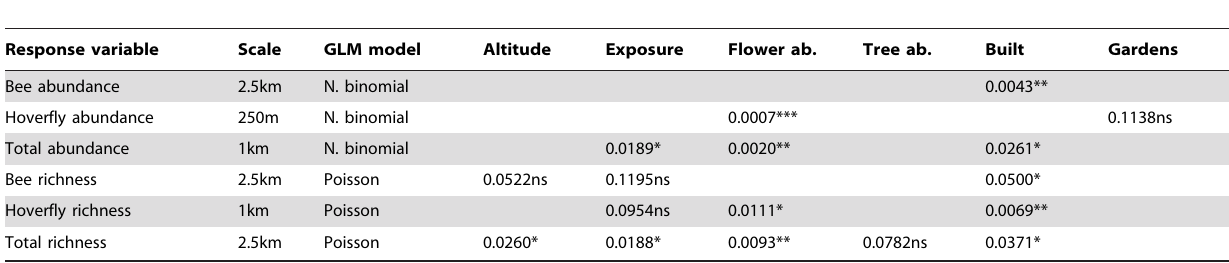
Table 3. Summary of the selected generalized linear models (GLM) for total bee abundance, total hoverfly abundance,